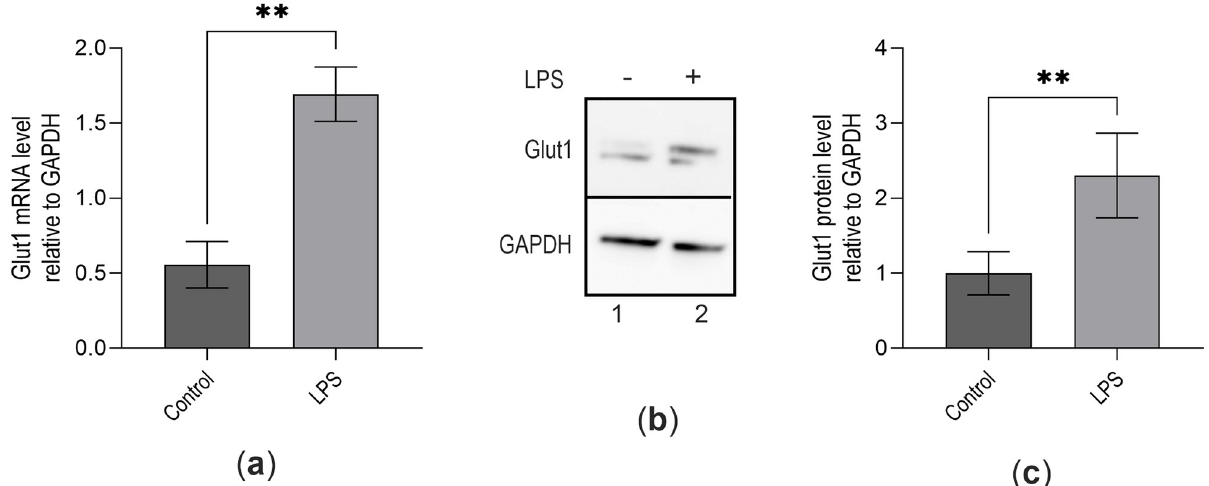
Fig 1. LPS induces Glut1 expression in macrophages. ( a – c ) RAW264.7 cells were treated with LPS (100 ng/mL) for 4 h, total RNA was isolated, reverse transcribed to cDNA, and RT-qPCR analyzed the expression Glut1. GAPDH was used as a control. The expression (relative to GAPDH) of Glut1 mRNA is shown in panel ( a ). Protein was extracted from macrophages and analyzed by Western blot using antibodies against Glut1 and GAPDH (loading control) ( b ). Quantifications (using ImageJ software) are shown in panel ( c ). Each experiment was repeated at least with three parallel replicates. Data represent mean ± SD (n = 3); �� p < 0.001, ��� p <